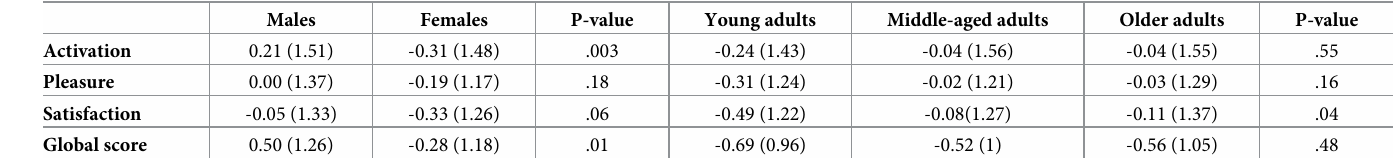
Table 7. Mean and standard deviation of the three dimensions and of the global score of STS after COVID-19.